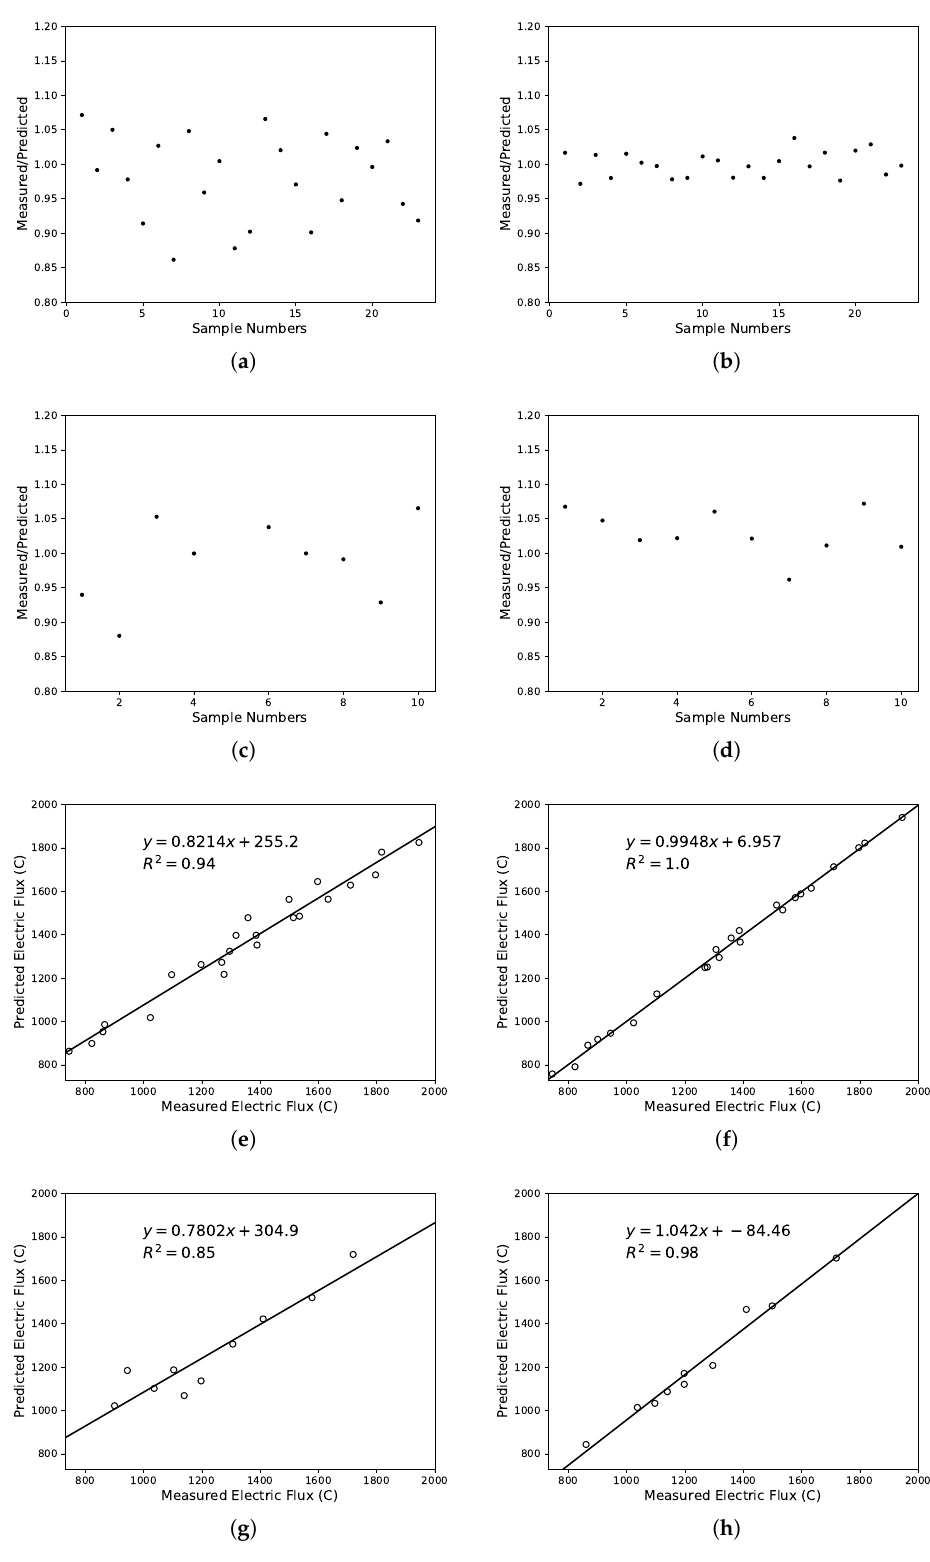
Figure 6. Comparison of the ration between the measured and predicted electric flux using SVM and LS-SVM. The ratio: ( a ) SVM in training set, ( b ) LS-SVM in training set, ( c ) SVM in test set, ( d ) LS-SVM in test set; The correlation: ( e ) SVM in training set, ( f ) LS-SVM in training set, ( g ) SVM in test set, ( h ) LS-SVM in test set.